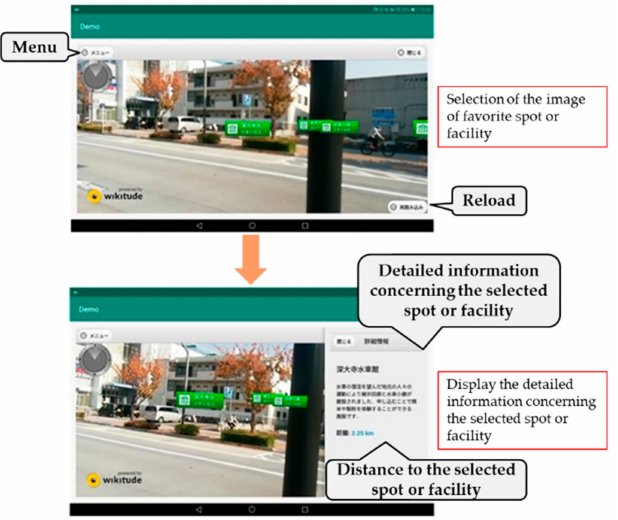
Figure 8. Screen of the display function of sightseeing spots and tourism-related facilities using